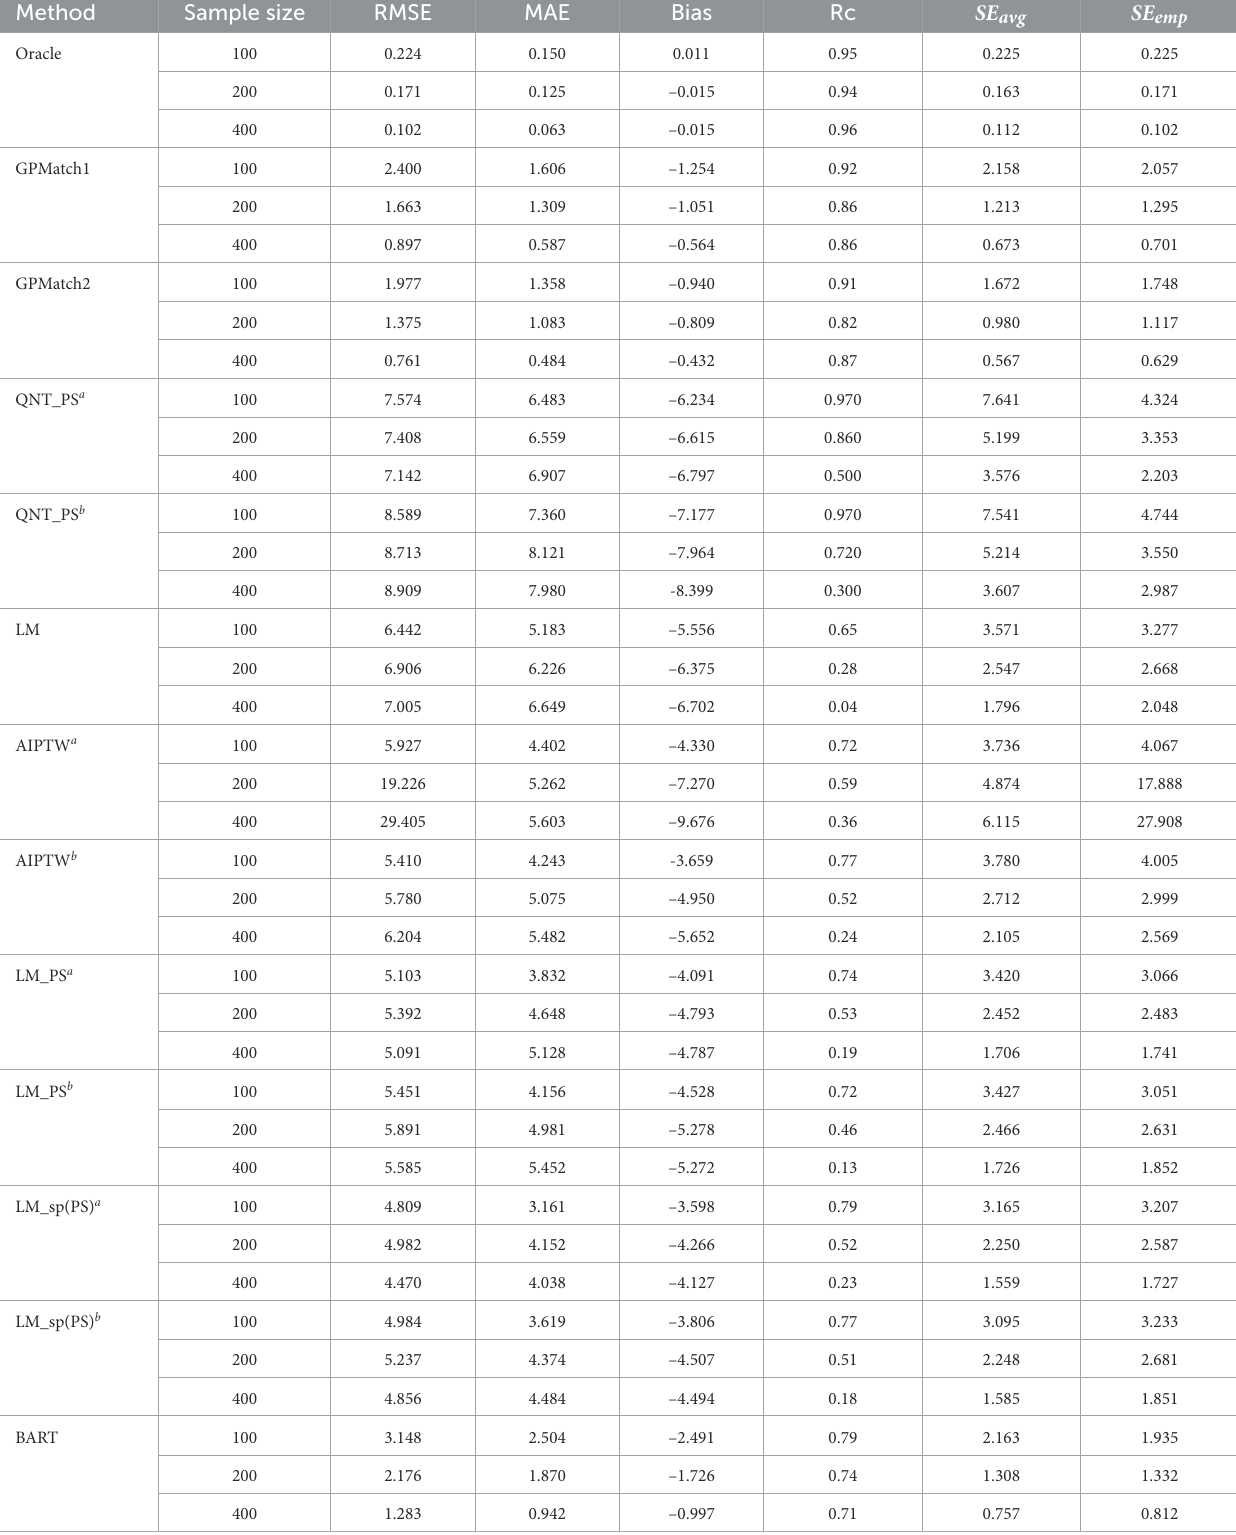
TABLE 3 Results of ATE estimates using different methods under the Kang and Shafer dual misspecification